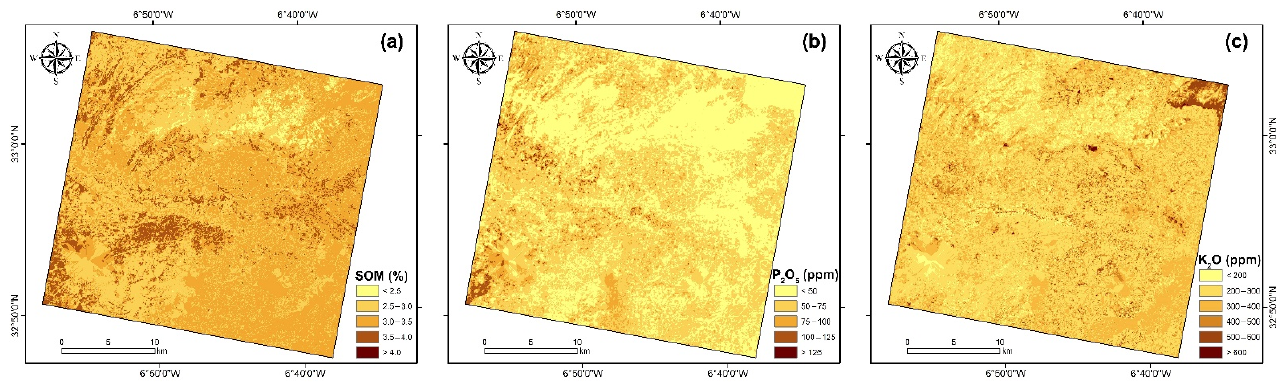
Figure 7. Soil fertility maps (FertiMaps) of ( a ) soil organic matter (SOM), ( b ) available soil phosphorus (P 2 O 5 ), and ( c ) potassium (K 2 O) contents predicted using RF-OK models within the Khouribga region, at 30 m spatial resolution.